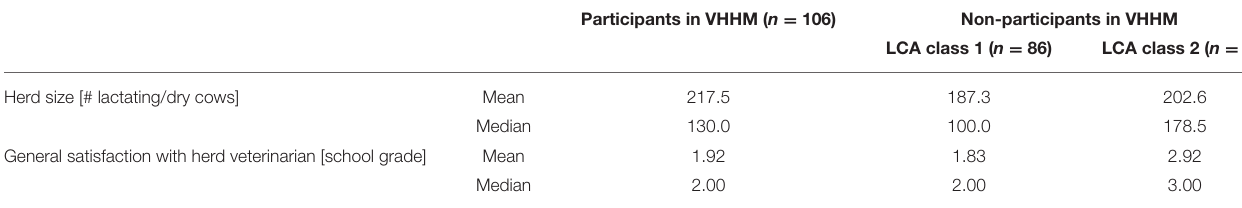
TABLE 12 | Comparison: VHHM-participants and non-VHHM participants with interest in